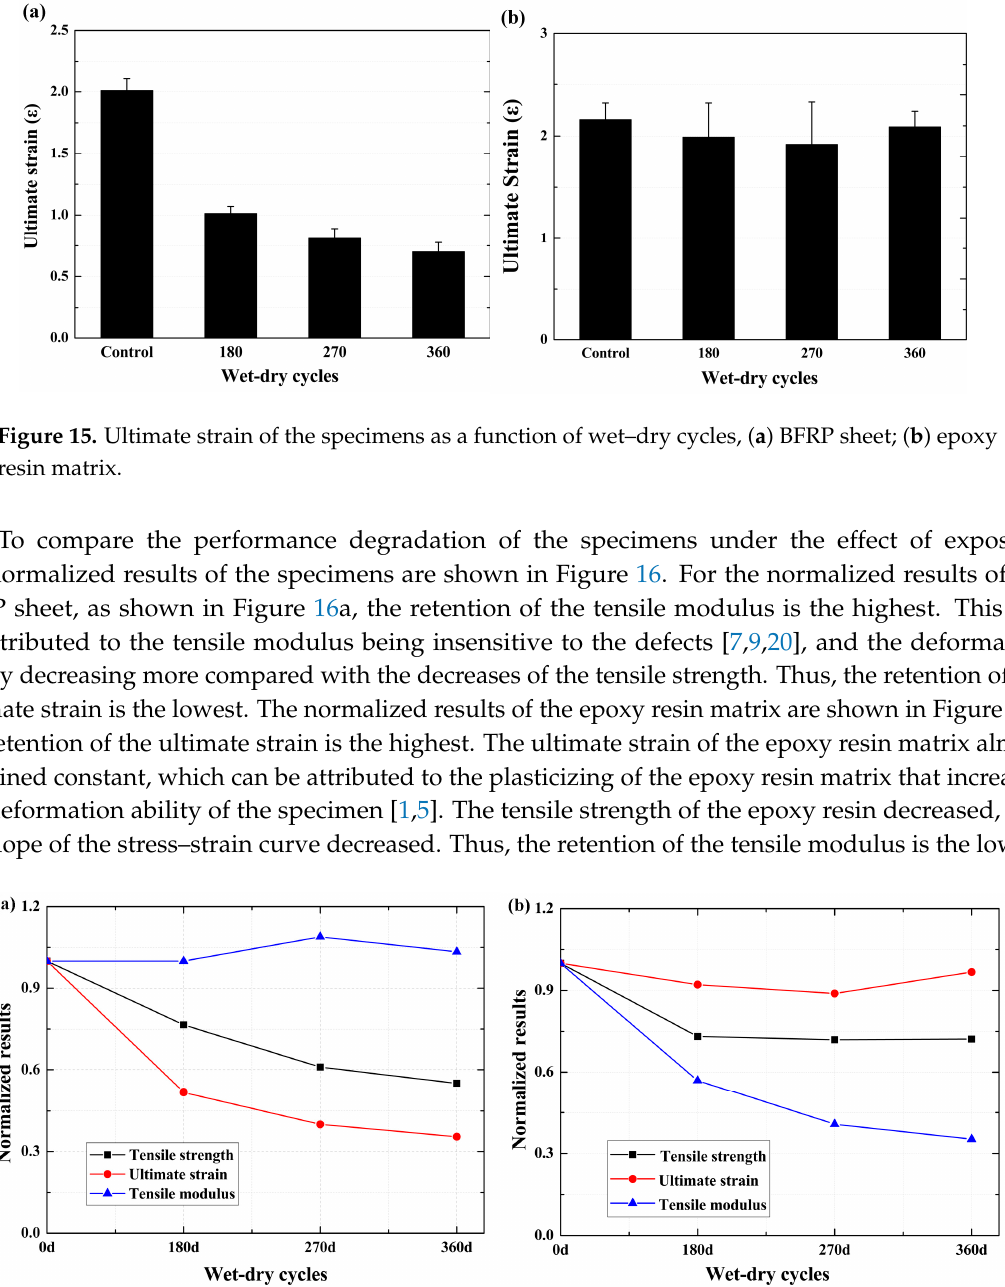
Figure 16. Mechanical properties of the specimens with an increasing number of wet–dry cycles, ( a ) BFRP sheets; ( b ) epoxy resin matrix. ( a ) BFRP sheets; ( b ) epoxy resin